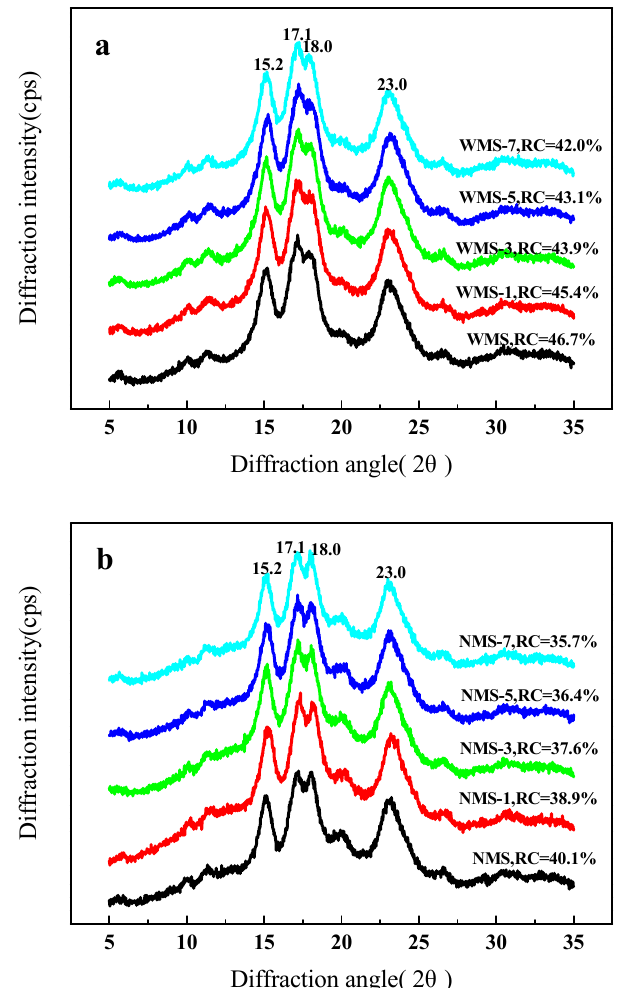
Figure 3. XRD patterns of maize starch samples treated by APPJ. ( a ) Waxy maize starch ( b ), normal maize starch.